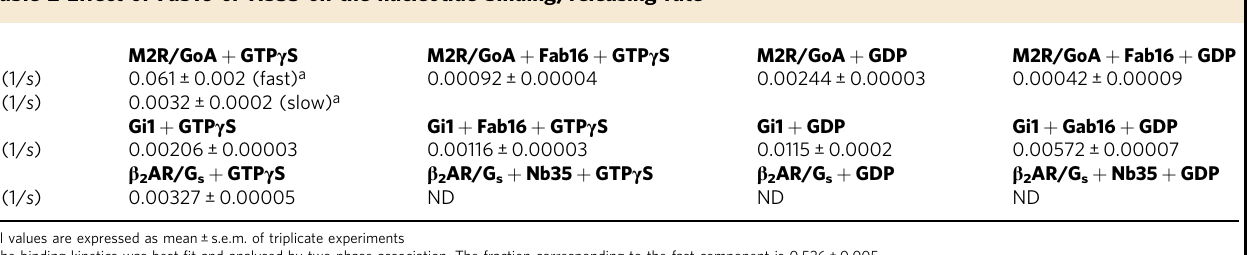
Table 2 Effect of Fab16 or Nb35 on the nucleotide-binding/releasing